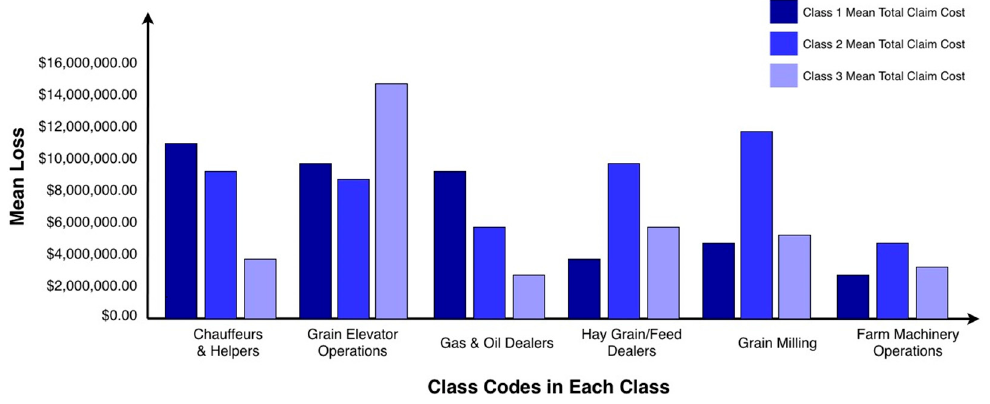
Figure 1. Categorization of occupational injuries mean loss per latent class.